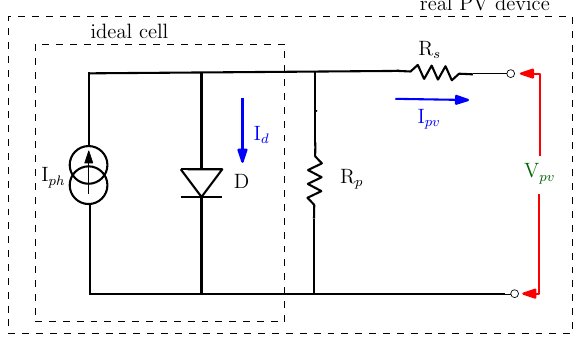
Figure 2. The equivalent circuit of a photovoltaic